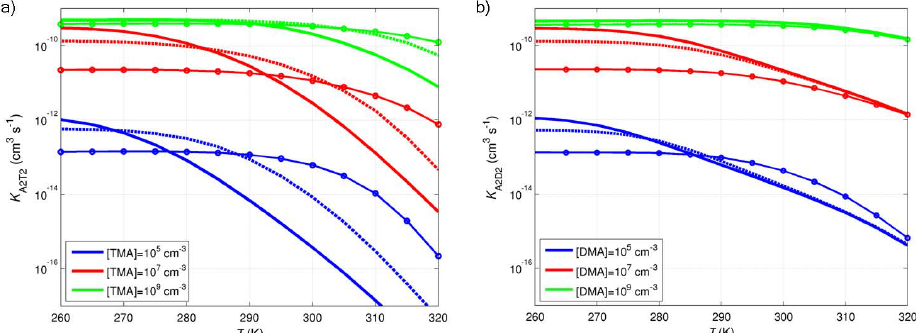
Fig. 4. The modelled coefficients K 22 , the ratio of J 22 and squared total sulphuric acid monomer concentration, as a function of temperature for (a) A 2 T 2 -clusters and (b) A 2 D 2 -clusters in cases when only one amine is present. The solid lines correspond to total H 2 SO 4 monomer concentration [A 1 , tot ] = 10 6 cm − 3 , the dashed to [A 1 , tot ] = 10 7 cm − 3 and the solid lines with circles to [A 1 , tot ] = 10 8 cm − 3 .